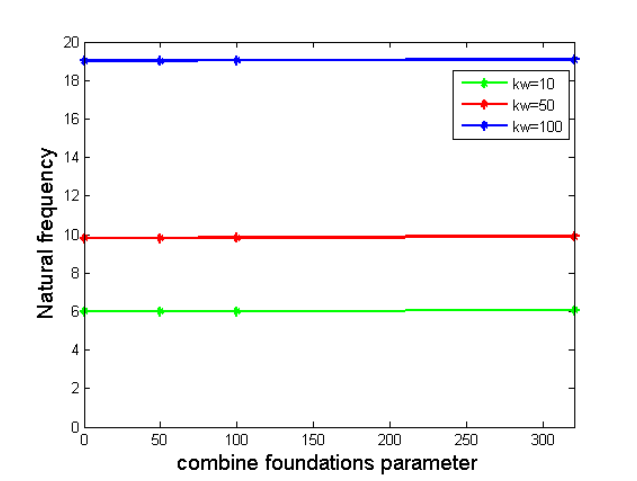
Figure 5. Influence of combine elastic foundations on natural frequency clamped edge condition